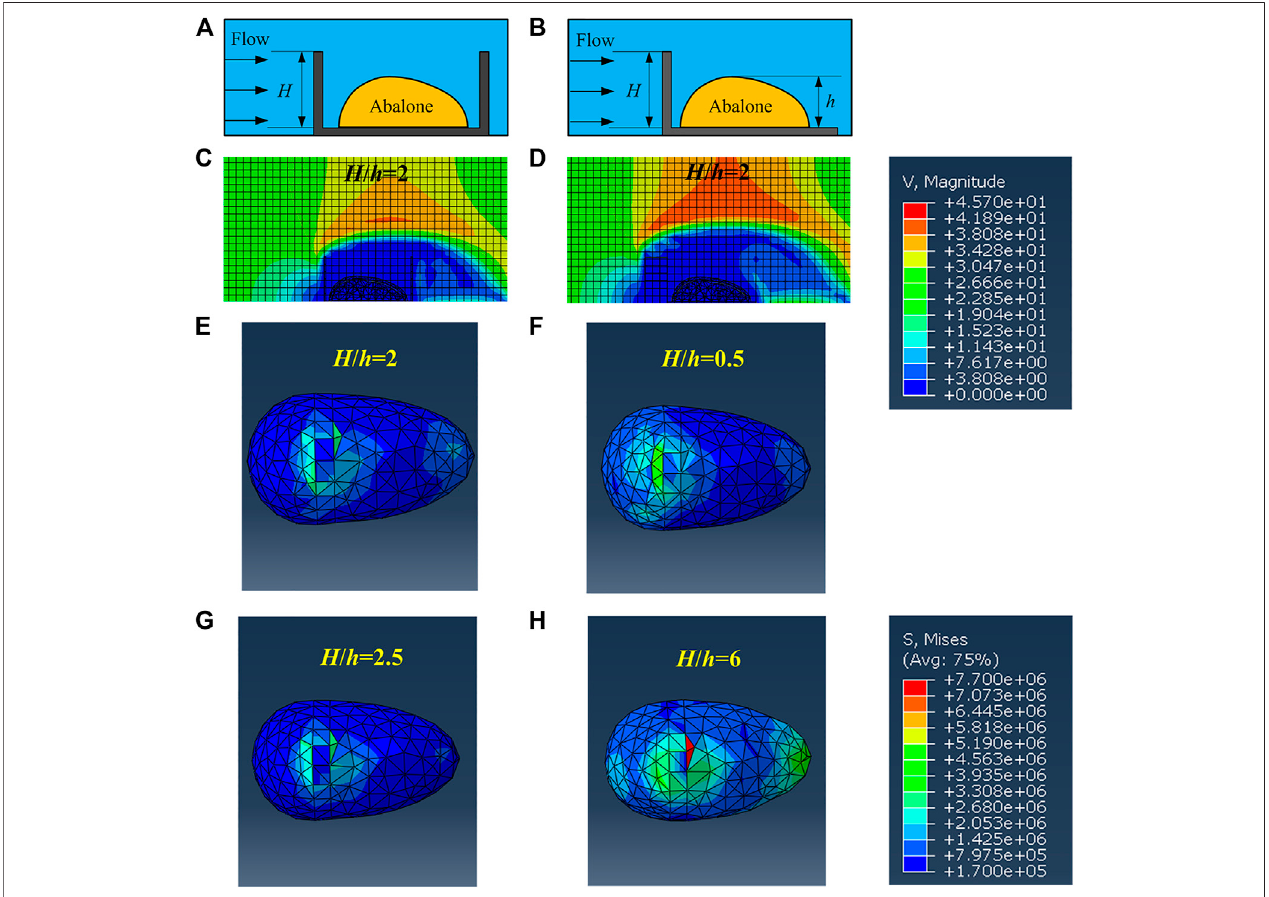
FIGURE8| Twomodelsincludingthetroughandtheobstaclerelatedwiththeabaloneandtheclouddiagramofthevelocity fi eldandthepedal ’ sstress (A) and (B) areschematicsofthemodelsoftroughandobstacle (C) and (D) aretheclouddiagramsofthevelocity fi eldinthetroughandbehindtheobstacle (E) and (F) arethecloud diagrams of the pedal ’ s stress in the trough (G) and (H) are the cloud diagrams of the pedal ’ s stress behind the obstacle.